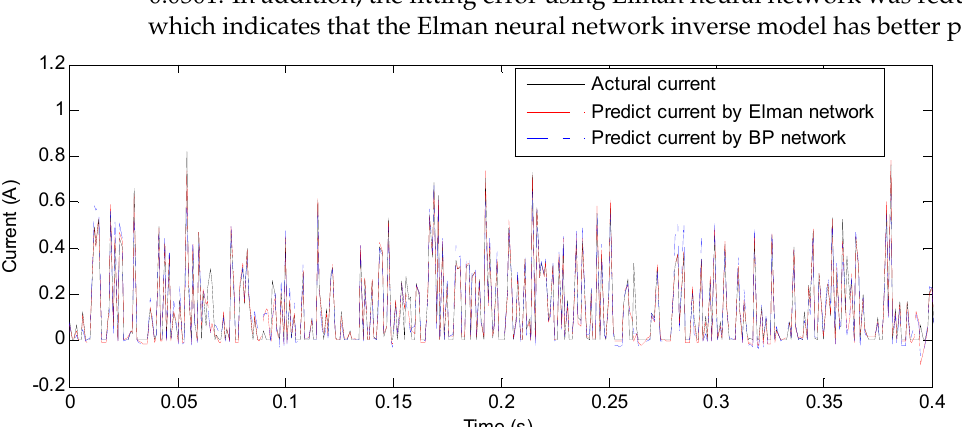
Figure 11. The predicted values of the current using the Elman and back propagation (BP) networks.